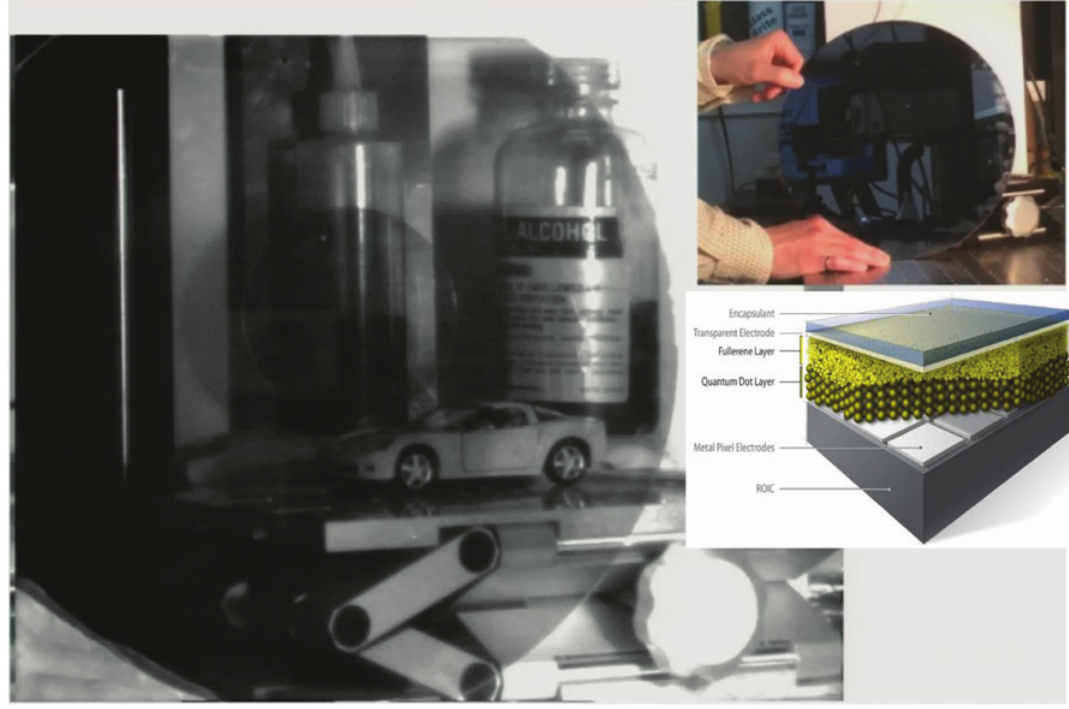
Figure 9: An image from the PbS CQD-based focal plane array (FPA) camera operating in the SWIR band. The CQD-based camera can see through a silicon wafer. The first inset shows the image taken using a normal visible camera. Second inset image is the PbS CQD-based focal plane array (FPA) structure